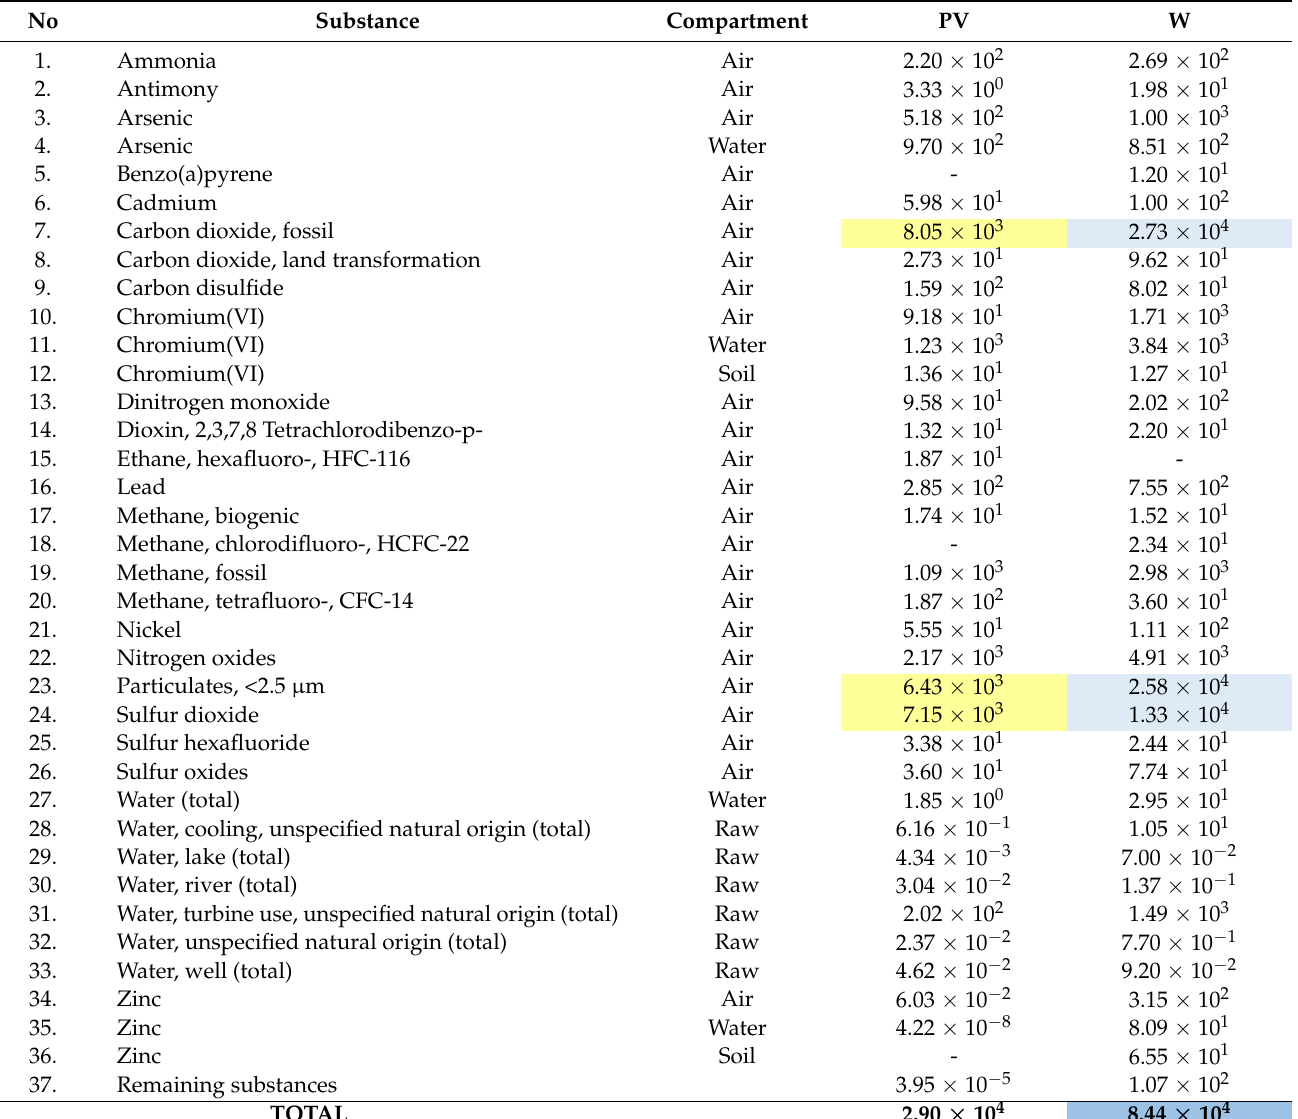
Table 7. Grouping and weighting results of environmental effects for human health present in the life cycle of wind (W) and photovoltaic (PV) power plants (unit: